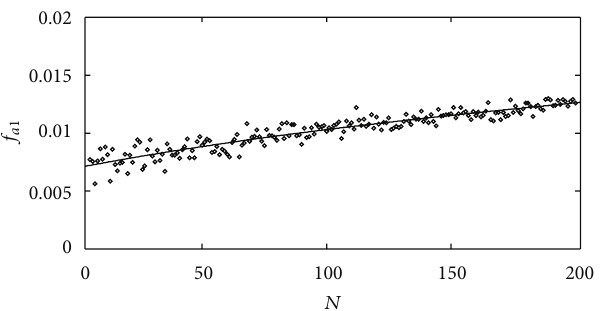
Figure 8: Relationship between 𝑓 𝑎1 and 𝑁